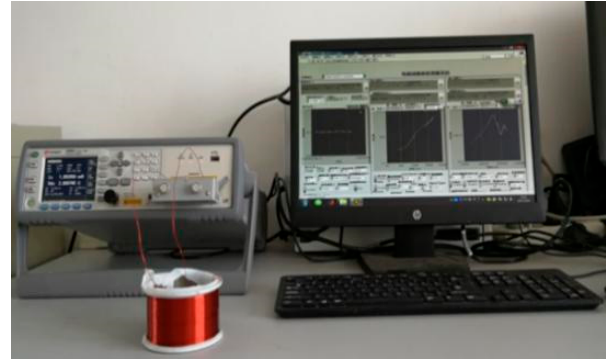
Figure 14. Impedance measurement platform for the hand-wound coil.